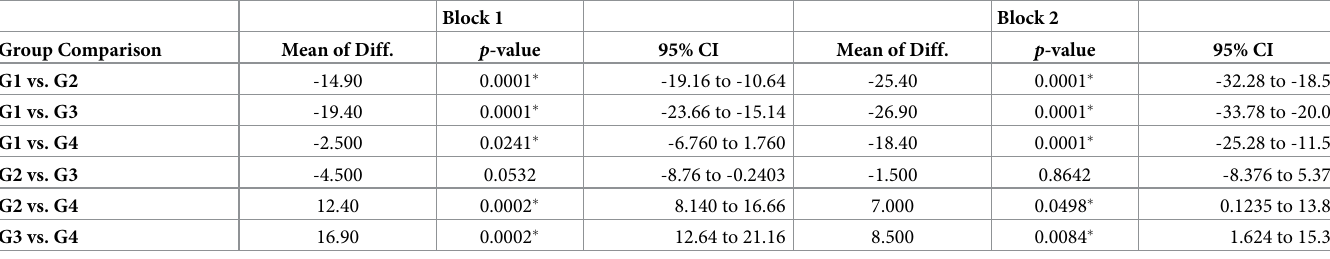
Table 1. Bonferroni’s multiple comparison test to compare insertion torque values between the groups in the two synthetic bone blocks. Block 1 Block 2 Group Comparison Mean of